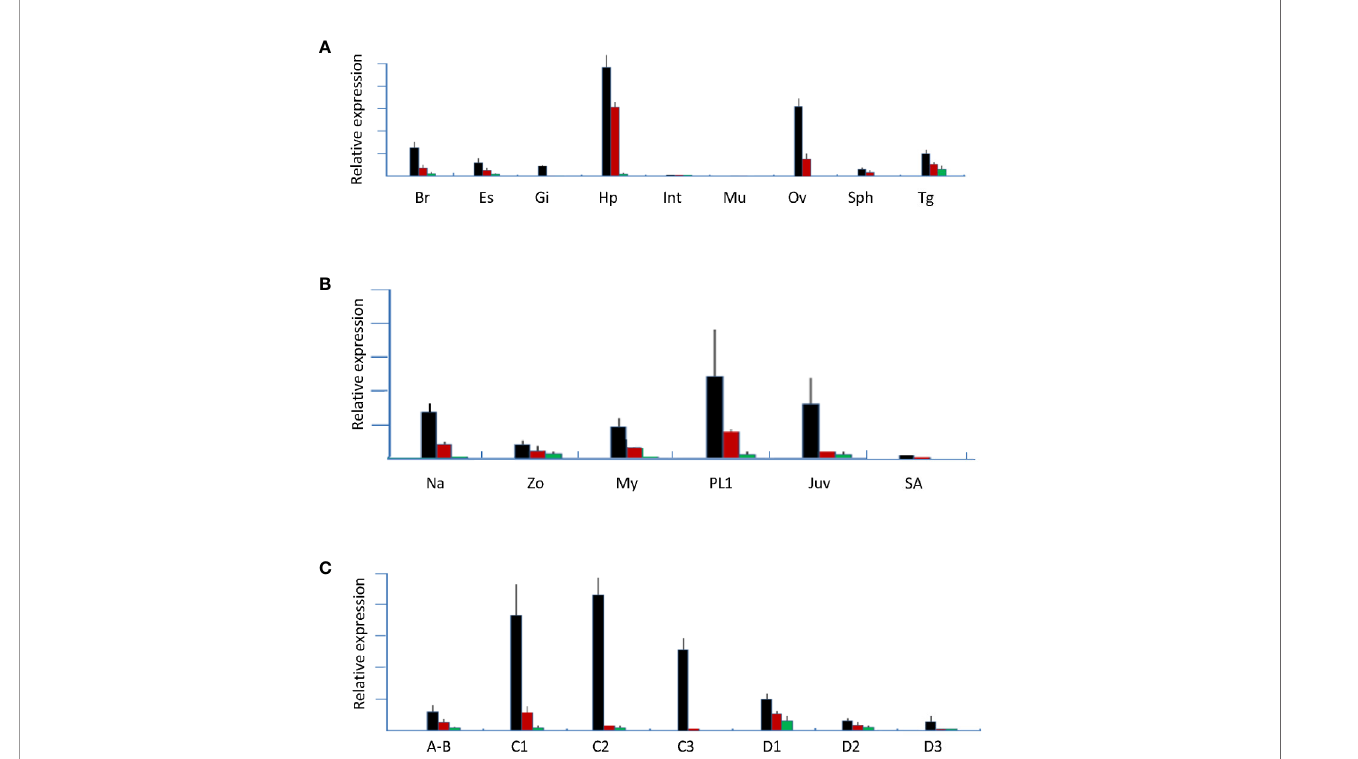
FIGURE 7 | Gene expression analysis of LvVg1 , LvVg2 , and LvVg3 . The black bars are for LvVg1 , the red bars are for LvVg2 , and the green bars are for LvVg3 (N = 3). (A) Tissue speci fi c expression of Vgs . Brain (Br), eyestalk (Es), gill (Gi), hepatopancreas (Hp), intestine (Int), muscle (Mu), ovary (Ov), spermatophore (Sph), and thoracic ganglion (Tg); (B) Expression of different LvVg transcripts in the nauplius (Na), zoea (Zo), mysis (My), post-larvae (PL1), juvenile (Juv), and subadult (SA); (C) Molt cycle expression pattern in the hepatopancreas. Postmolt (A, B); early-mid intermolt (C1 – 2), late intermolt (C3), early premolt (D1), middle premolt (D2), and late premolt